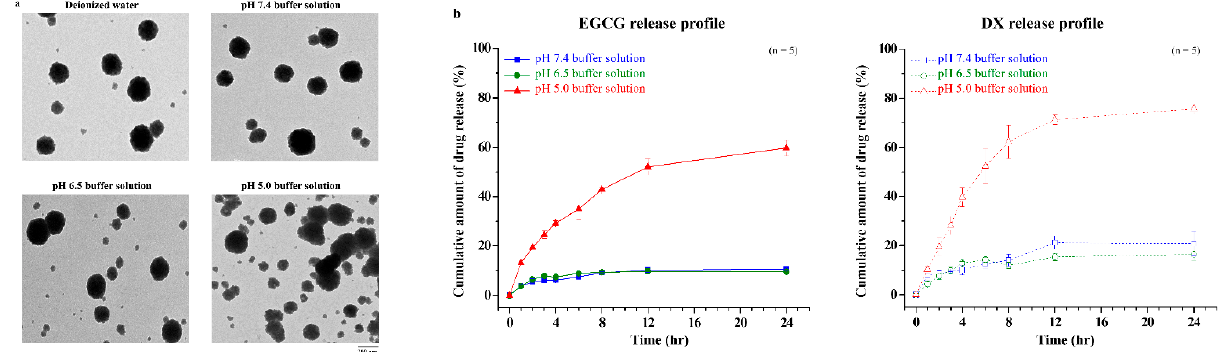
Figure 2. ( a ) Transmission electron micrographs of nanoparticles in buffer solution with different pH values; ( b ) The release profile of EGCG and DX in varying pH environments at 37 ℃ . Data is expressed as mean ± SD ( n = 5).